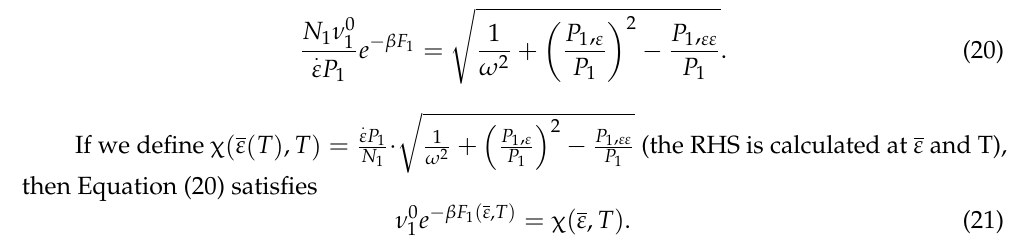
(cid:3040) . A fit to the results for